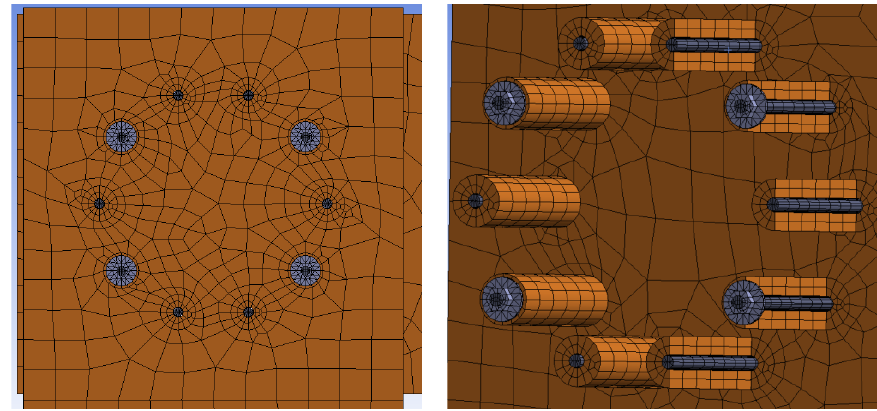
Figure 10. Finite element mech for Experiment A, bolts and dowels.